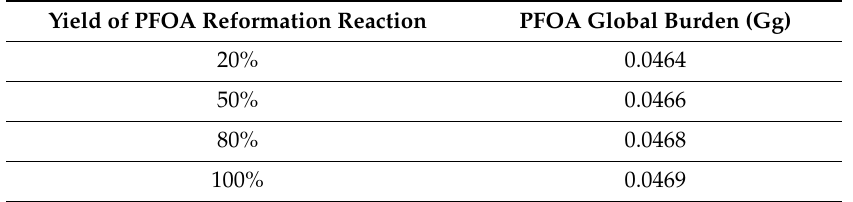
Table 3. Global burden data for PFOA across four simulations where the yield of the PFOA-reforming oxidation of HPE was varied between 20% and 100%.